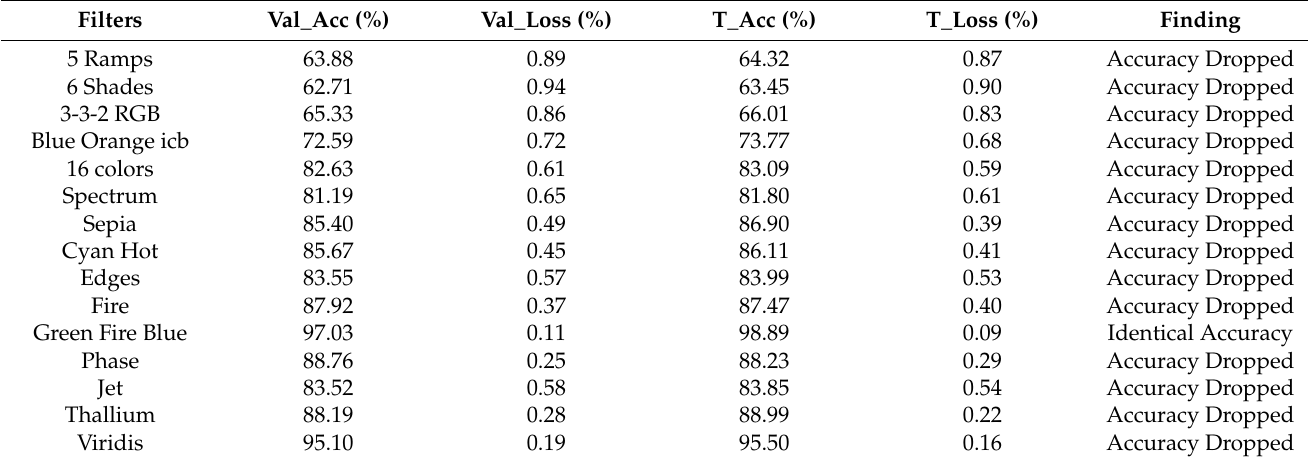
Table 3. Analyses of performances of various filters.